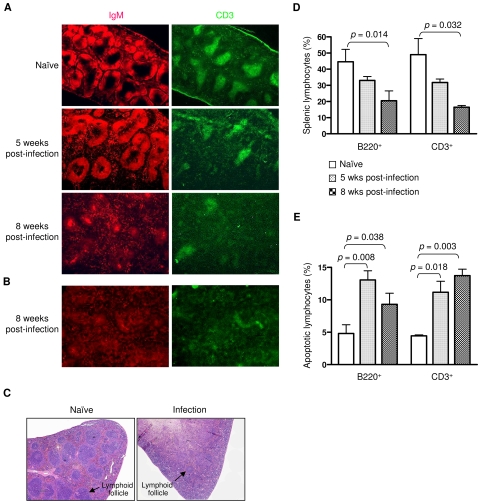

S. japonicum infection disrupts the structure of the splenic lymphoid follicles.(A, B) Splenic cryosections were stained with anti-IgM-rhodamine and anti-CD3-FITC to reveal the follicle B zone (red) and T zone (green), respectively. Six OBF-1 wild-type mice (A) and three C57B/6 mice (B) were analyzed in each experiment. Representative images are shown. Magnification: 40×. (C) Paraffin-embedded spleen sections prepared from C56BL/6 mice of 8 weeks post-infection were stained with H&E to reveal lymphoid follicles. Naïve mice were used as controls. Three mice in each group were analyzed. Magnification: 40×. (D) Splenic cells from naïve or infected OBF-1 wild-type mice (six mice for each group) were stained with anti-B220 or anti-CD3. Splenic B220+ or CD3+ cells were analyzed by flow cytometry. (E) Splenic cells from these mice (six mice for each group) were stained with Annexin V plus anti-B220 or anti-CD3. Apoptotic splenic B220+ or CD3+ cells are shown. Results are presented as a mean±SD. Statistically significant differences between the compared groups are given as p values.